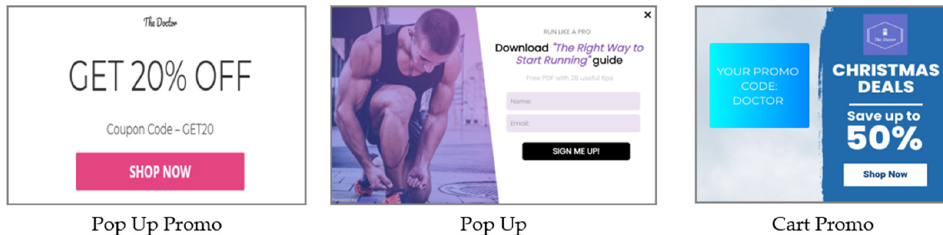
Figure 3. Constructed pop-up and promotional advertisements.